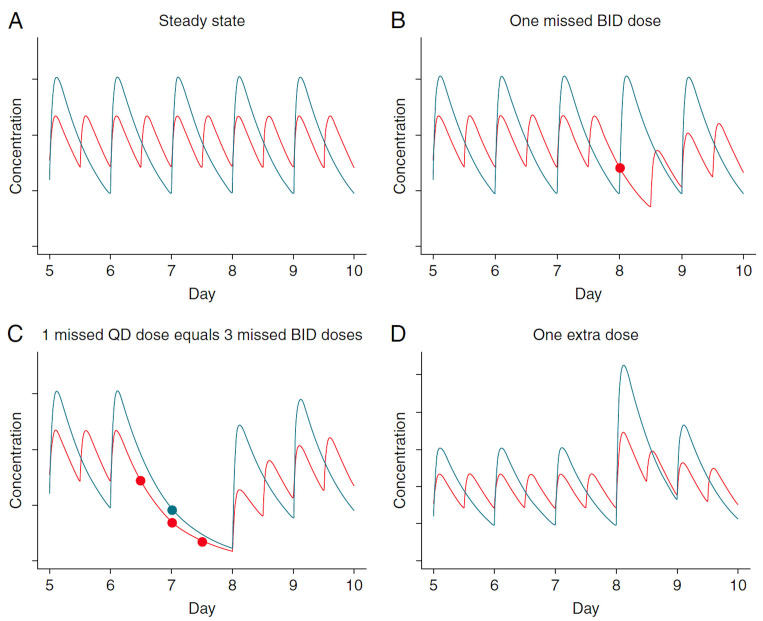
Once-daily vs. twice-daily dosing: difference between intake and predicted biological impact in general.Different patterns of non-adherence lead to different exposition to “risk” between once-daily and twice-daily drugs. These graphs illustrate the theoretical pharmacokinetic proﬁles of a dose X administered once-daily (QD) and a dose X/2 administered twice-daily (BID) for a drug with a half-life of about 12 hours and a Tmax of 3 hours. (
A) The peak-to-trough ratio is much smaller for the BID than the QD dosing. (
B) The concentration after a single missed BID dose (red dot) is similar to the expected trough concentration of QD dosing, suggesting that missing a single dose of a twice-daily dosing regimen should not be therapeutically critical. (
C) The pharmacological equivalent of missing a single dose in a once-daily regimen (blue dot) is missing three consecutive doses (red dots) of a twice-daily dosing regimen. (
D) Taking an extra dose results in a much higher peak for the QD than for the BID dosing regimen. This figure was reproduced from Heidbuchel H, Vrijens B. Non-vitamin k antagonist oral anticoagulants: Considerations on once- vs. Twice-daily regimens and their potential impact on medication adherence. EP Europace. 2015;17:1317-1318
24 by permission of Oxford University Press.